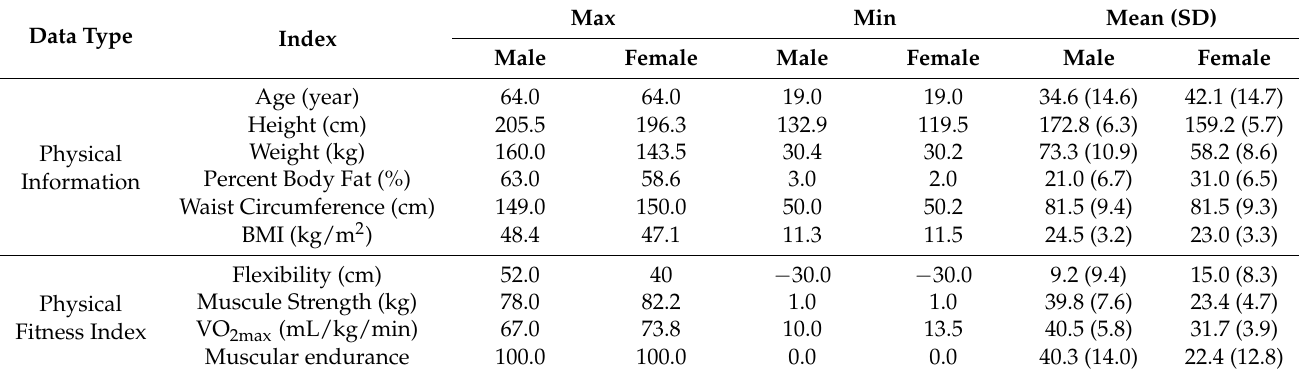
Table 1. Summary of the NFA dataset used for training and validation of the ANN model. In total, 197,719 sets (male: 87,188 sets, female: 110,531 sets) of data were used. Data